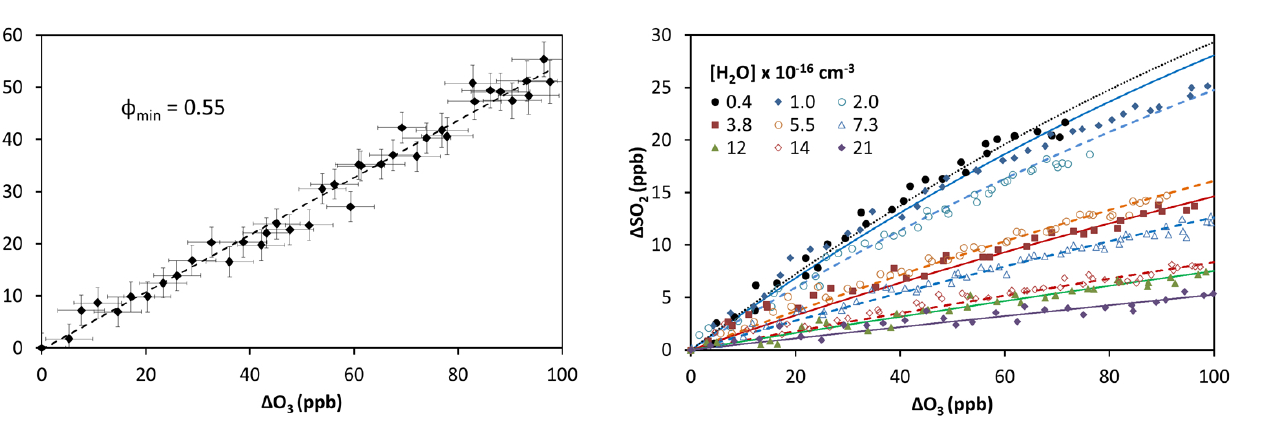
Figure 1. (cid:49) SO 2 vs. (cid:49) O 3 during the excess SO 2 experiments ([H 2 O] < 5 × 10 15 cm − 3 ) . The gradient determines the minimum SCI yield ( ϕ min ) from isoprene ozonolysis.